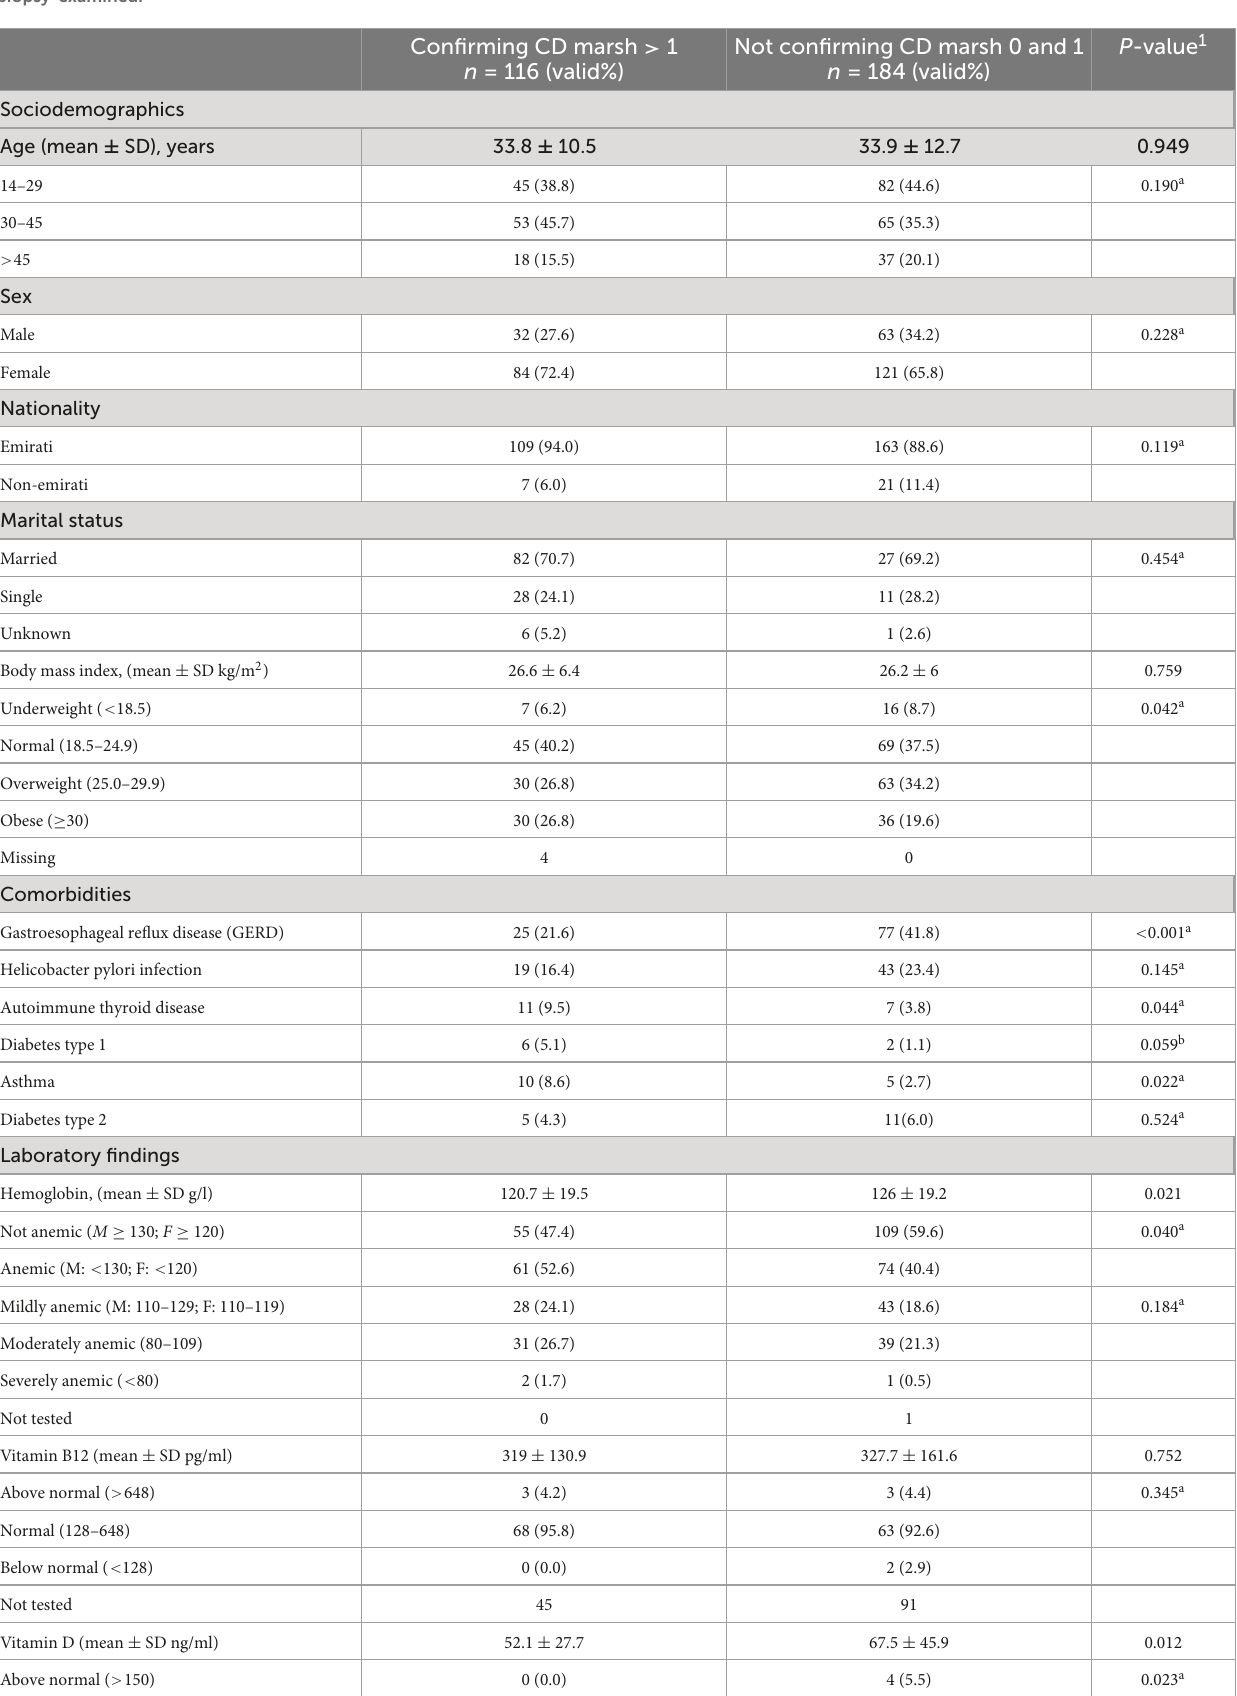
TABLE 2 Socio-demographic characteristics, co-morbidities, and laboratory findings of the serologically positive 300 patients and who were biopsy-examined. Confirming CD marsh >